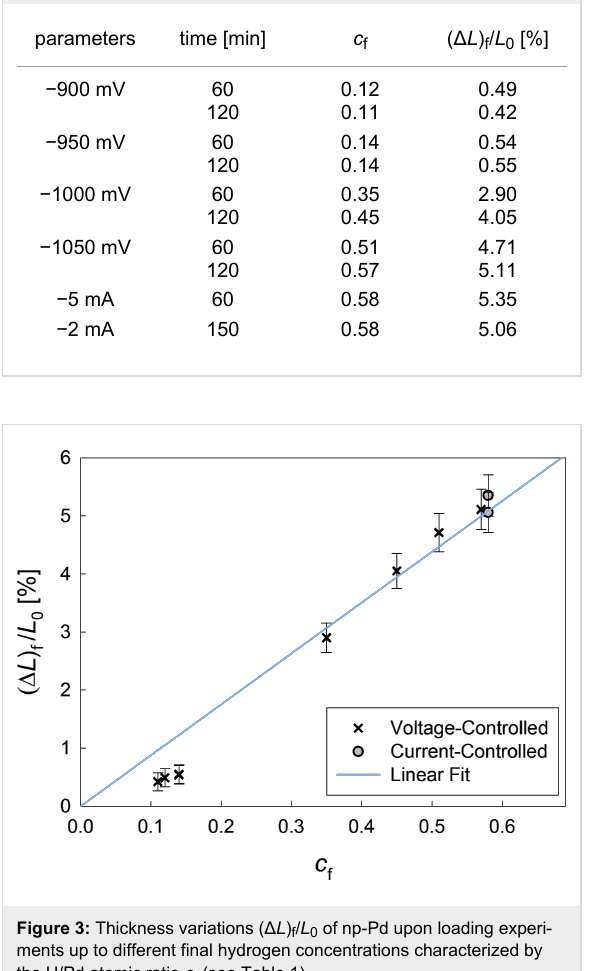
Table 1: Dilatometrically monitoring hydrogen absorption upon voltage-controlled charging procedures at quoted voltages U Ag/AgCl or current-controlled charging at quoted currents, resulting in a final H/Pd atomic ratio c f associated with a final thickness increase ( Δ L ) f / L 0 (see Figure 3).